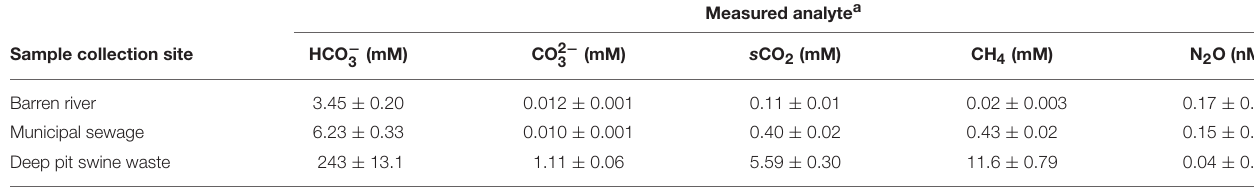
TABLE 2 | Bicarbonate, carbonate and dissolved gas